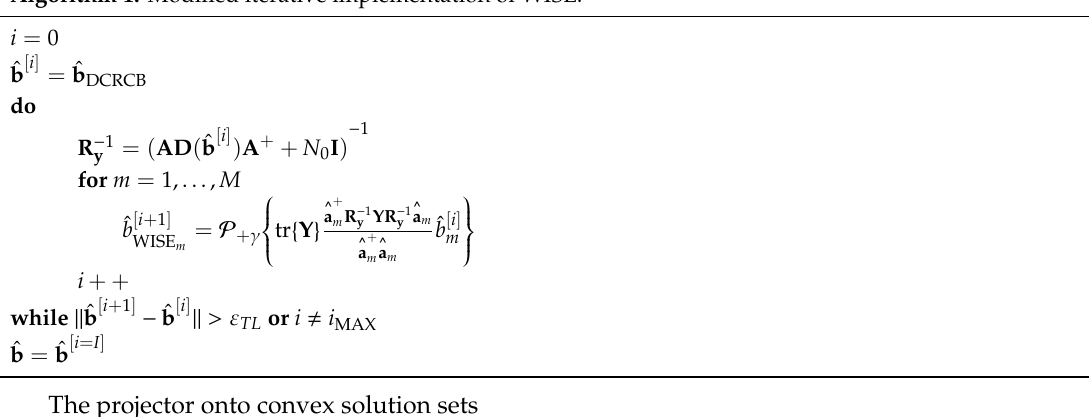
Algorithm 1. Modified iterative implementation of